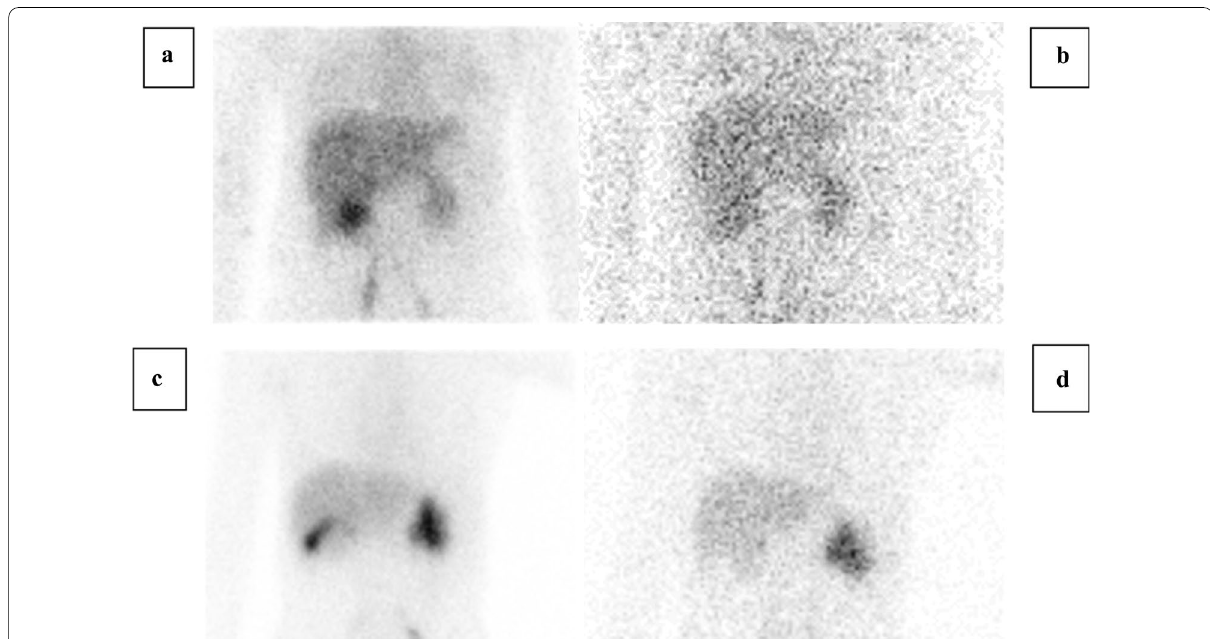
Fig. 1 Anterior images obtained 30 min after injection demonstrate [ 99m Tc]Tc-MAG3 activity in the gallbladder of subjects 10 ( a ) and 13 ( c ) whereas the corresponding [ 99m Tc]Tc(CO) 3 (NTA) images ( b ) and ( d ) show no gallbladder